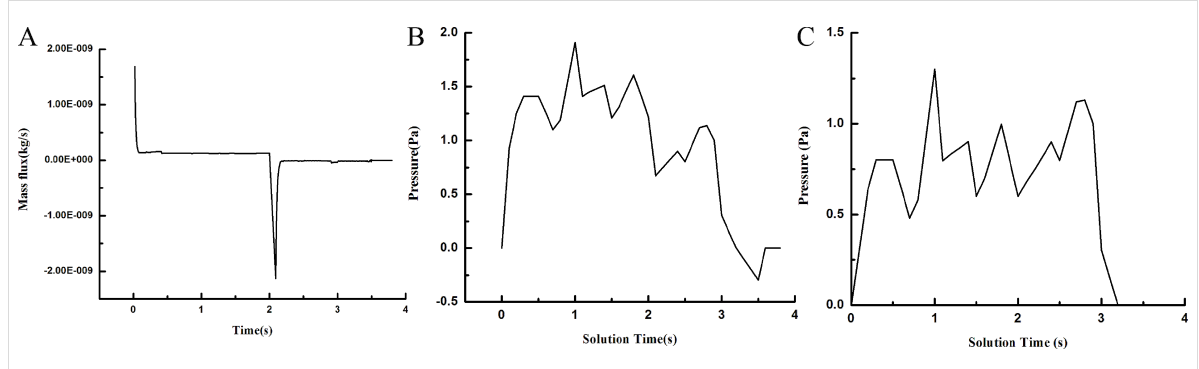
Figure 8: Blood flow changes in the venation of a hind wing of C. japonicus at the entrance (A); pressure change as a function of the time at rotation points q1 (B) and q2 (C).